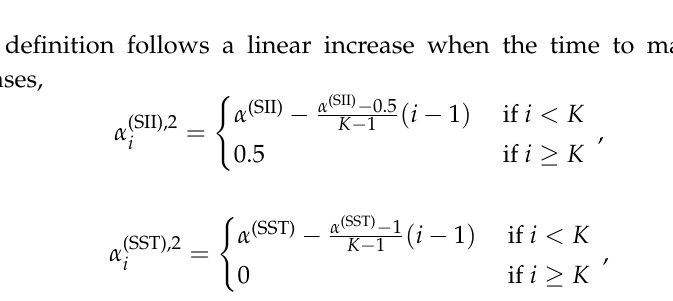
Figure 4. Different choices for the confidence vector, for a maturity T = 45 and a long-term threshold K =